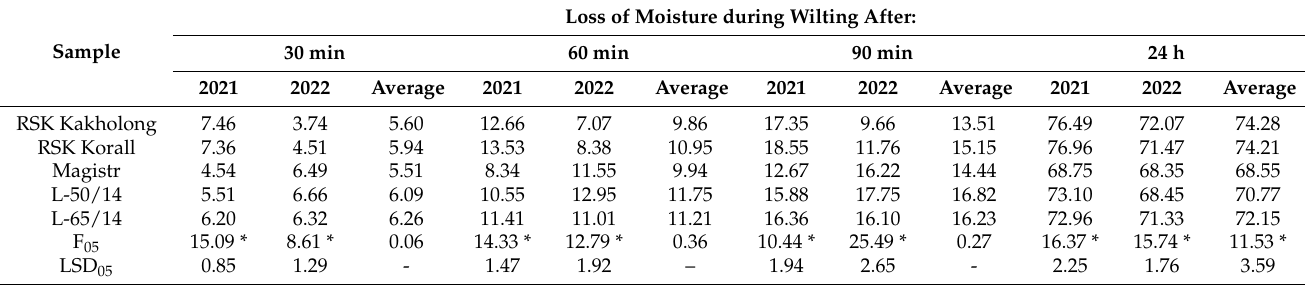
Table 5. Moisture loss by leaves of varieties and lines of grain sorghum in the process of wilting (2021–2022),